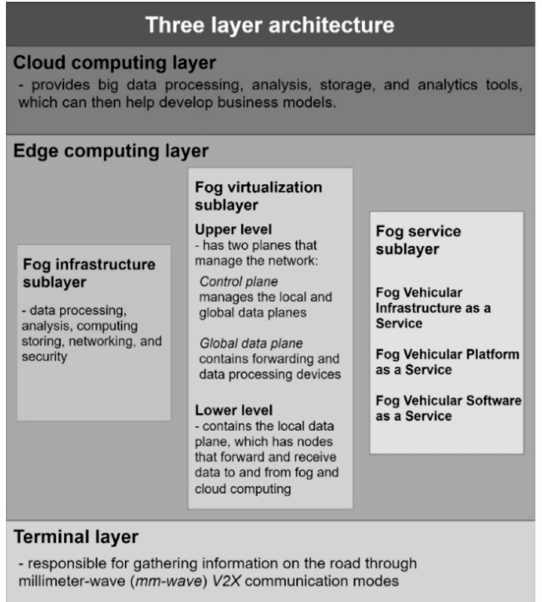
Figure 3. A three-layer architecture that covers the flaws of the last four, taking into account security and utilizing new network computing paradigms to achieve better performance and ease data dissemination in